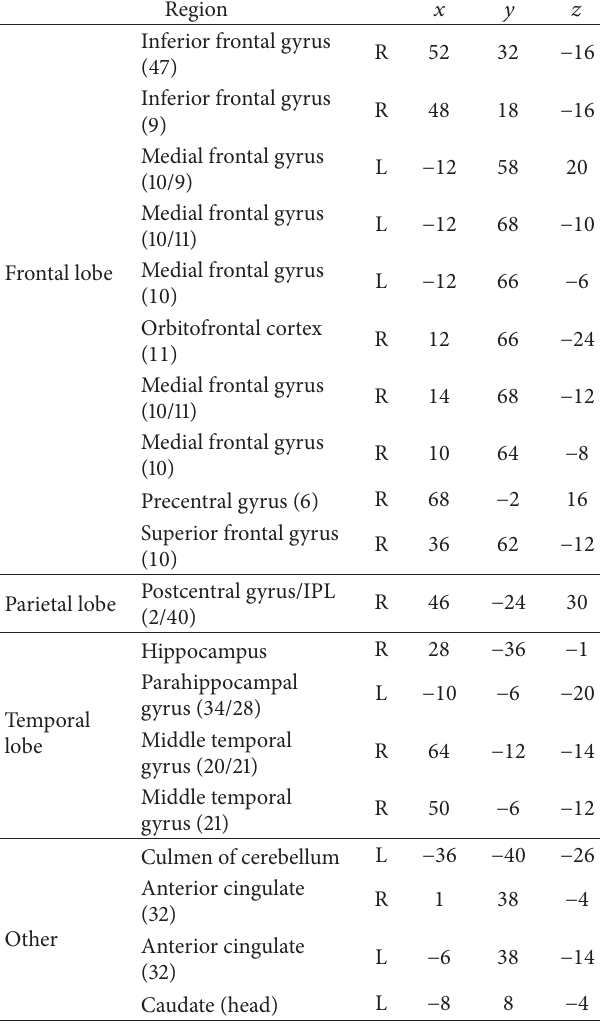
Table 2: Searchlight results for subsequent memory effects of explicit